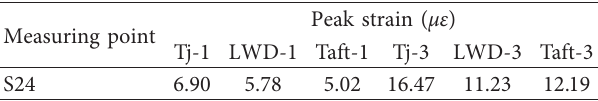
Figure 10: Strain of shallow and deep tunnels during the Tianjin wave. (a) Shallow tunnel. (b) Deep tunnel. Table 6: Peak strain of the deep tunnel at S24 for different cases. Measuring